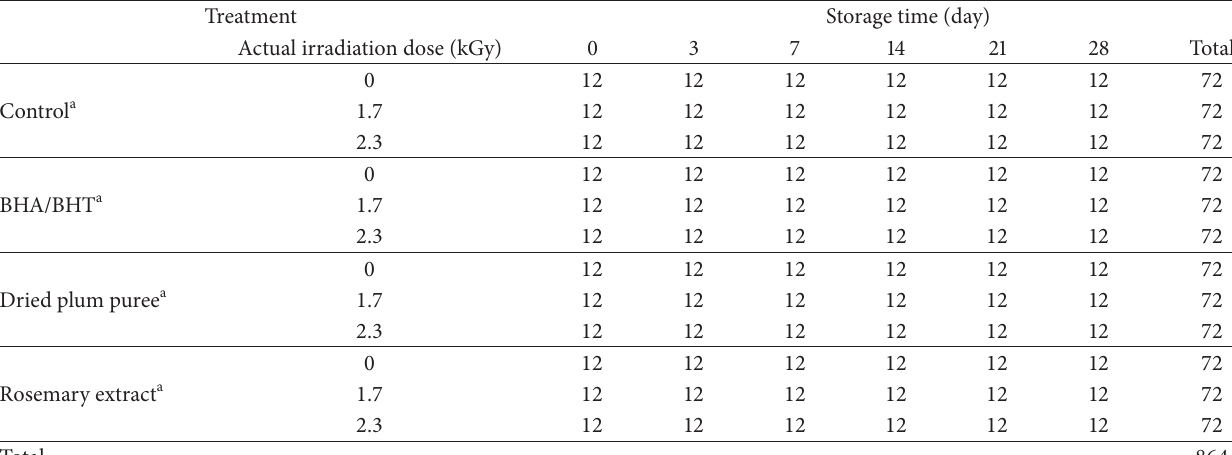
Table 1: Experimental design b of patty allocation by treatment and storage